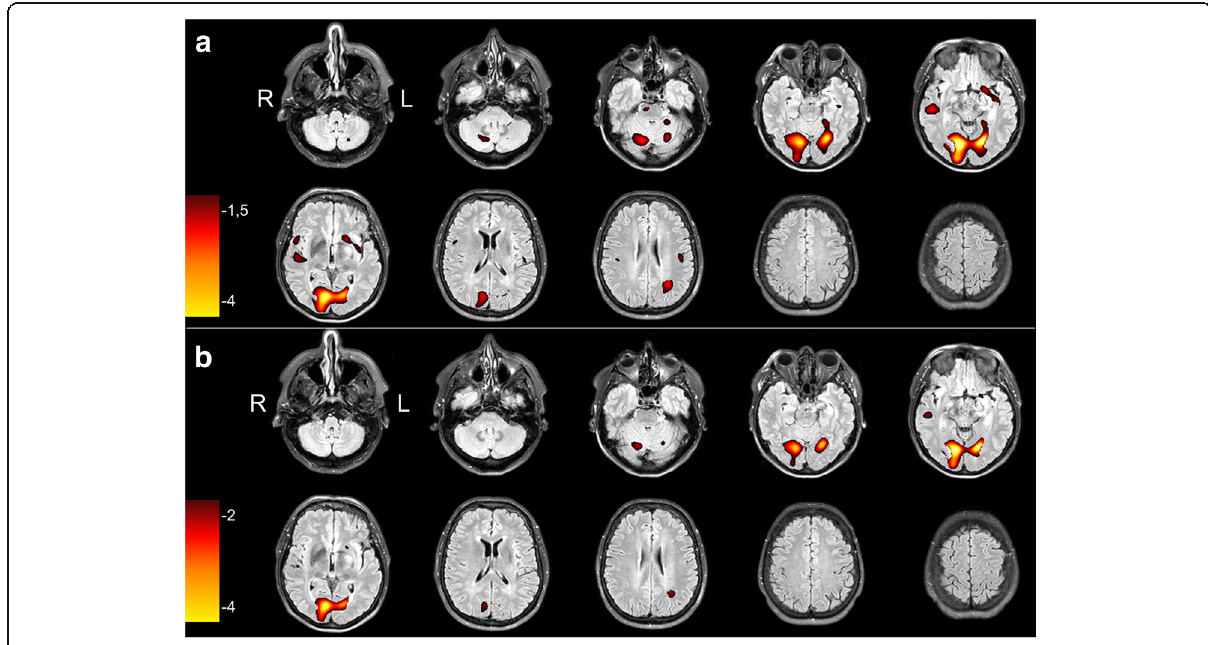
Fig. 1 Representative transverse SISCOM images of a 53-year-old patient with clinically temporal lobe epilepsy caused by an epidermoid tumor in the left occipital lobe, at the base of the skull at z -score thresholds of 1.5 and 2, superimposed on the preoperative MRI. Images are in radiological orientation. a The images at threshold of z = 1.5 show a widespread hyperperfusion in both occipital cortices but also a significant cluster in the right temporal lobe which was interpreted as the ictal onset zone with propagation to both occipital cortices. b The images at threshold of z = 2 show a clear focal hyperperfusion in the left occipital lobe with propagation towards the contralateral occipital lobe. The cluster in the right temporal lobe was much smaller and was interpreted as insignificant and caused by